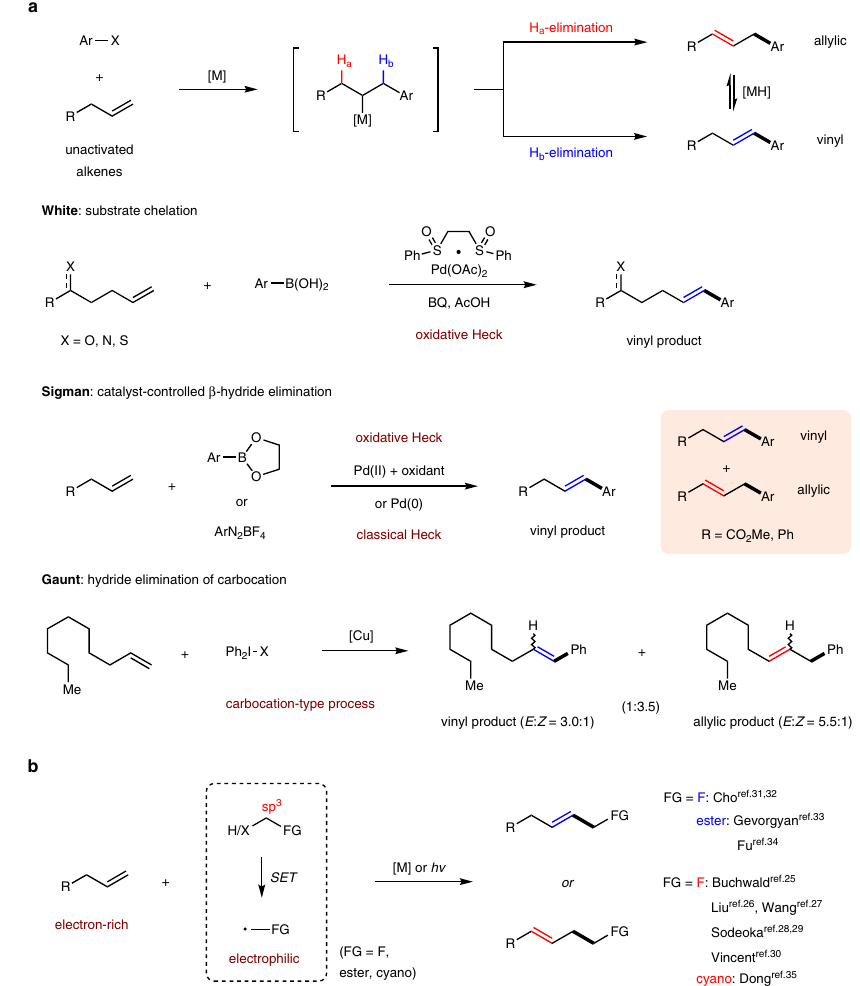
Fig.1|TheregioselectivitycompetitionforintermolecularHeck-typereactionofunactivatedalkenes.a TheregioselectivityinHeckreactionwitharylcomponents. b The regioselectivity in Heck-type reaction with alkyl electrophiles. BQ